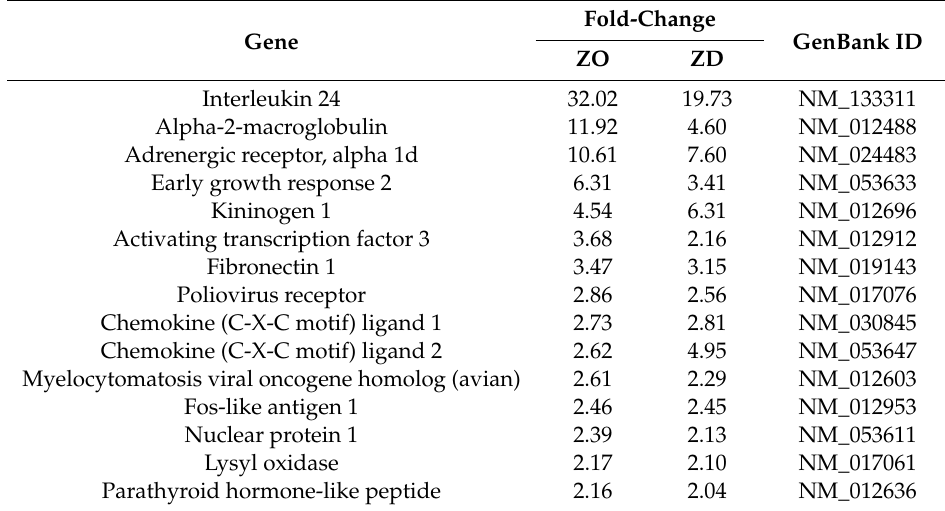
Figure 2. The genes were significantly altered in kidney cortex of Zucker rats. Circle graphs show the genes significantly altered ( ≥ 2 fold versus ZL) in kidney cortex of ZO (green) and ZD (blue) rats compared to ZL controls. Among them, 611 genes were commonly altered in the kidneys of ZO and ZD rats. n = 3 animals per group. Table 1. Genes that play roles in inflammation and cell proliferation whose expression in the kidney was similarly altered in Zucker obese (ZO) and Zucker diabetic (ZD) rats.